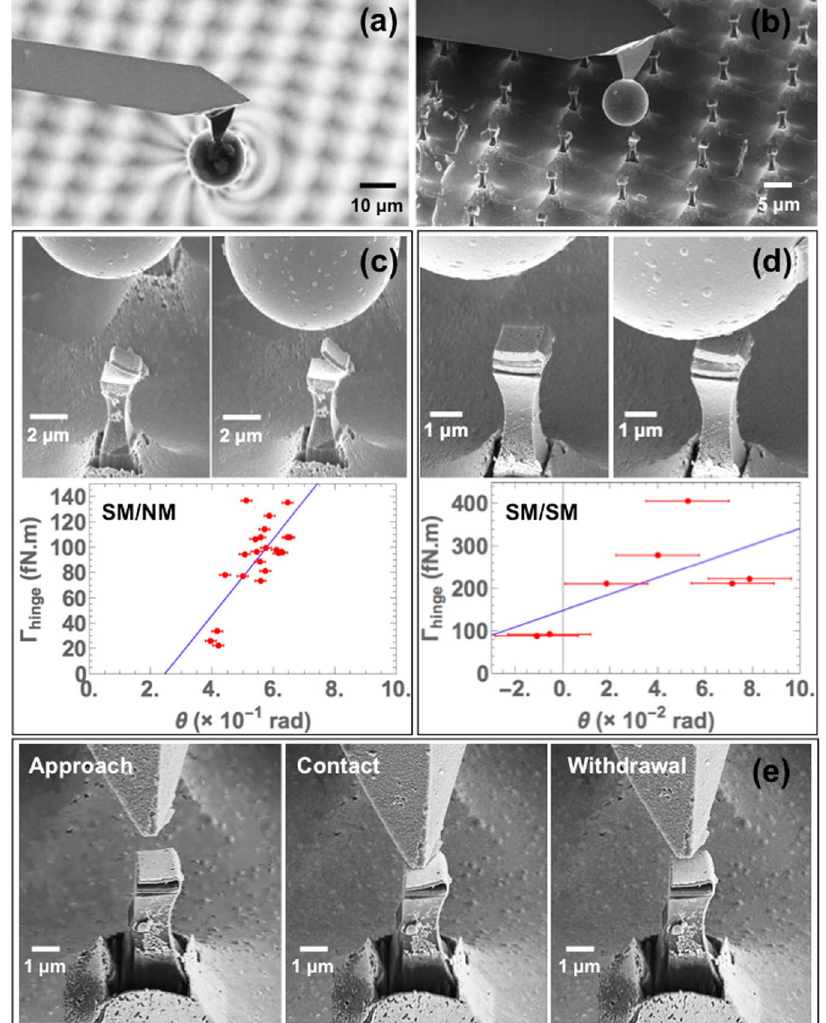
Figure 5. ( a ) FIB image of the magnetic microsphere mounted on the AFM tip. The field lines cause a deflection of the Ga + ions, which is very localized around the sphere and does not disturb the image acquisition as much as in the case of electrons. ( b ) Image of the probe targeting one the tweezers in the array of tweezers. Values of Γ hinge are calculated and plotted as a function of the measured tweezer opening angle in the case of a ( c ) SM/NM structure and a ( d ) SM/SM structure. ( e ) Test of the mechanical properties of the Au nanohinge with an AFM tip on SM/SM